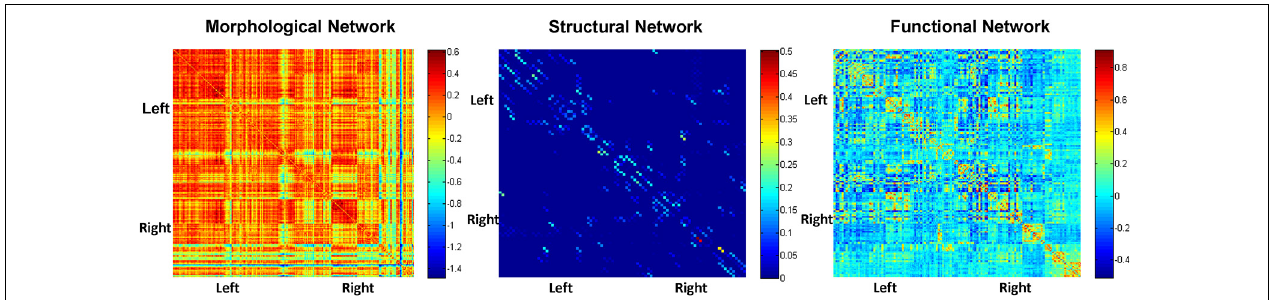
FIGURE 2 | Adjacent matrices of HCs at the group level based on morphological, structural, and functional network.